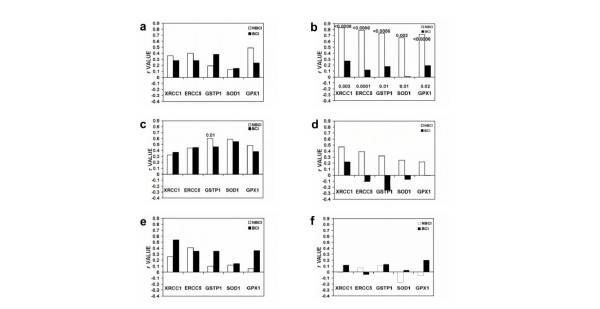
Correlation of each transcription factor with XRCC1, ERCC5, GSTP1, SOD1, or GPX1. (a-f) Each panel presents the correlation coefficients (r values) for one transcription factor in relation to each of the five genes: (a) CEBPB, (b) CEBPG, (c) E2F1, (d) E2F3, (e) E2F6, (f) EVI1. The p value for each significant correlation is provided above the bar. For CEBPG, presented in panel b, the difference in r value between non-BC individuals and BC individuals was significant or nearly significant for each correlated gene, and the p value for each comparison is provided below the corresponding pair of bars.